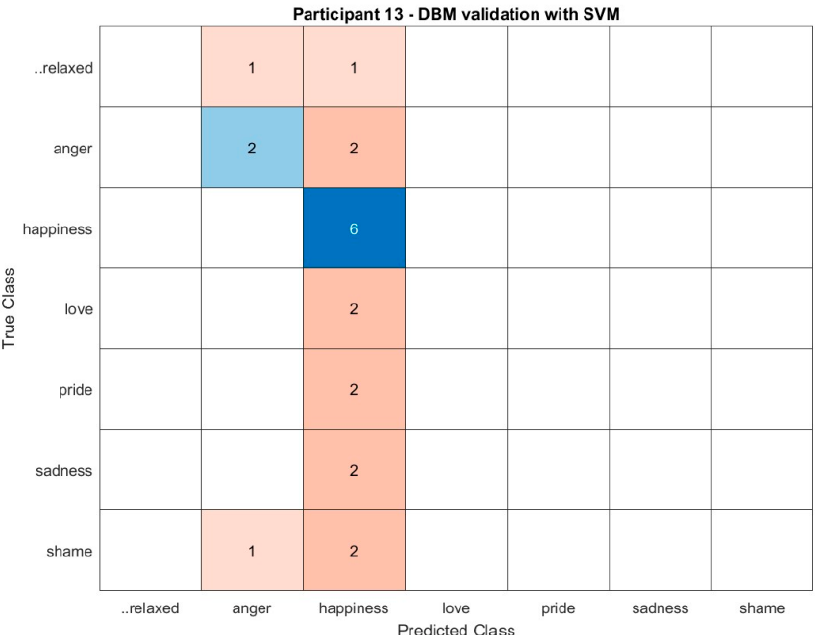
Figure 7. Confusion matrix of the classification of participant P13. The vertical axis represents the true class of the labels added by the participant. The horizontal axis represents the labels that were predicted by the classification algorithm. Each number, so every colour, indicates how many times each true class was predicted as each emotion on the horizontal axis.